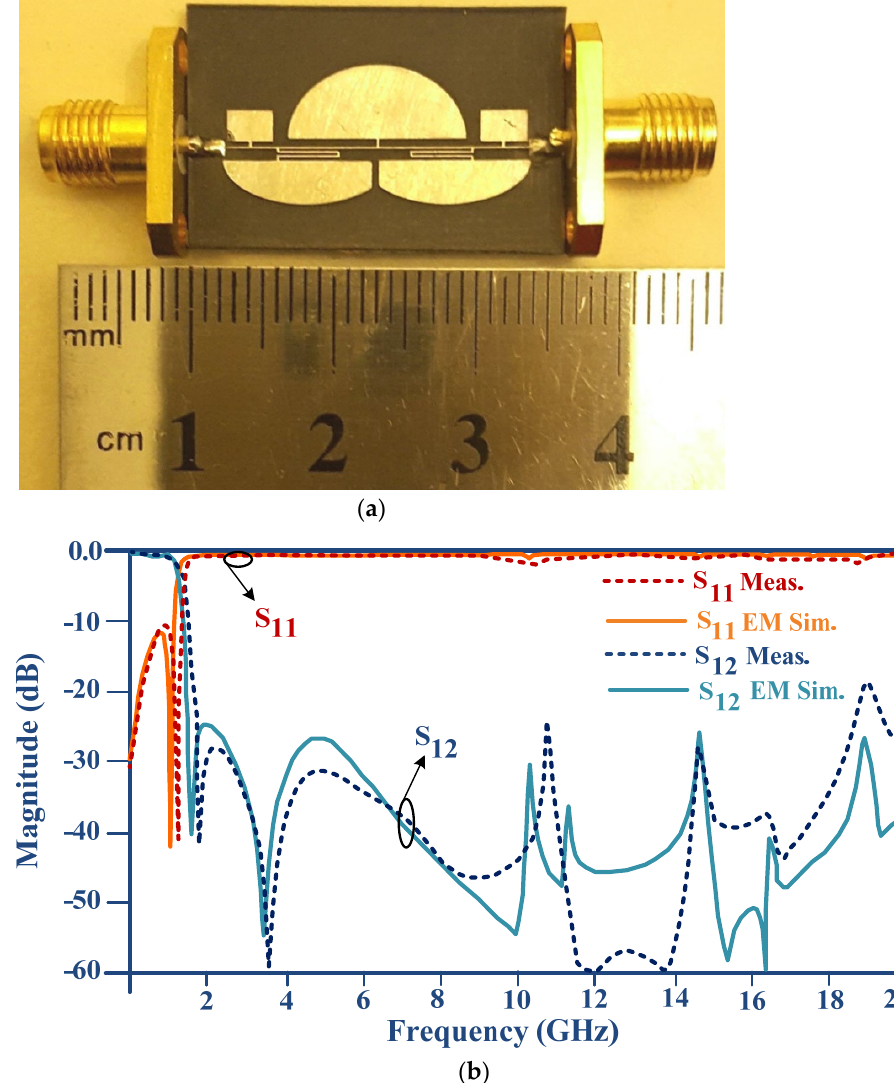
Figure 11. ( a ) The photo of the created filter. ( b ) Frequency responses of measurement and simulation.